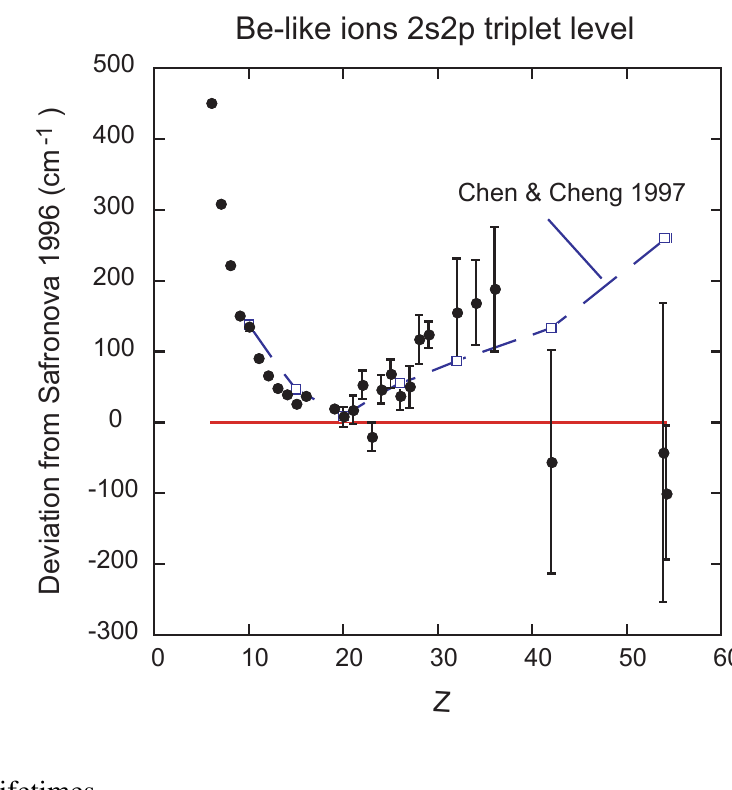
Figure 4. Measurements (full black symbols) and Relativistic Configuration Interaction (RCI) computational results (open blue squares and broken line [129]) of the 2s2p 3 P level in Be-like ions and their deviation from Many-Body Perturbation Theory (MBPT) computations by Safronova et al. [126]. Note that at low Z , the computation by Chen and Cheng [129] is close to experiment, while the other one is not, and vice versa at higher Z